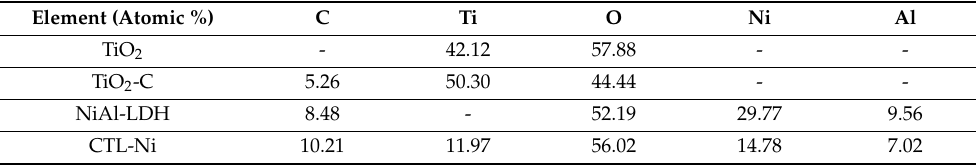
Table 1. Atomic weight percentages of the elements present in TiO 2 , TiO 2 -C, NiAl-LDH, and TiO 2 -C/NiLDH amalgam catalysts.